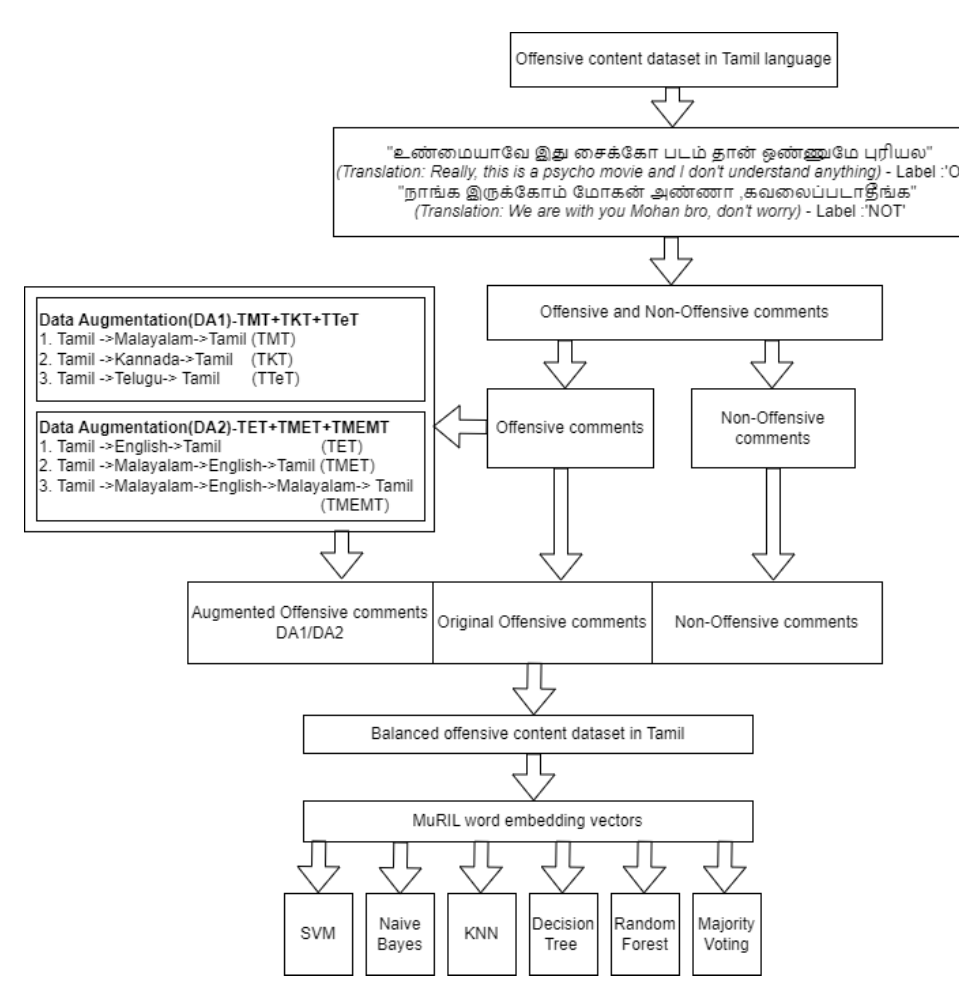
Figure 2. Architecture of proposed MTDOT method.